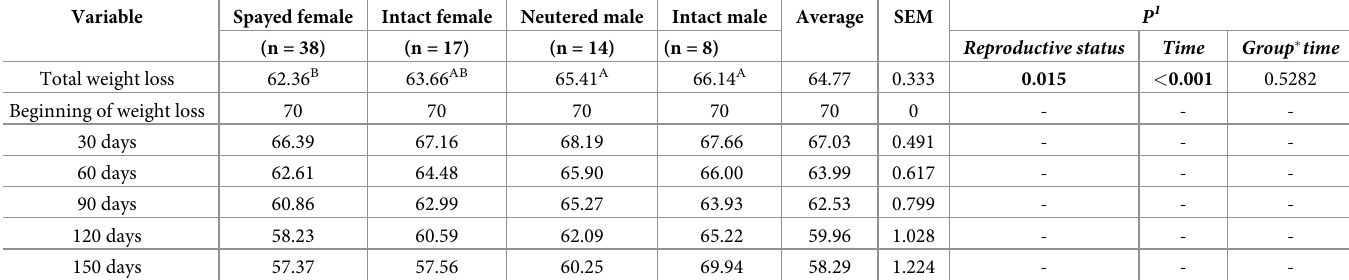
Table 1. Calorie intake per target weight 0.75 according with reproductive